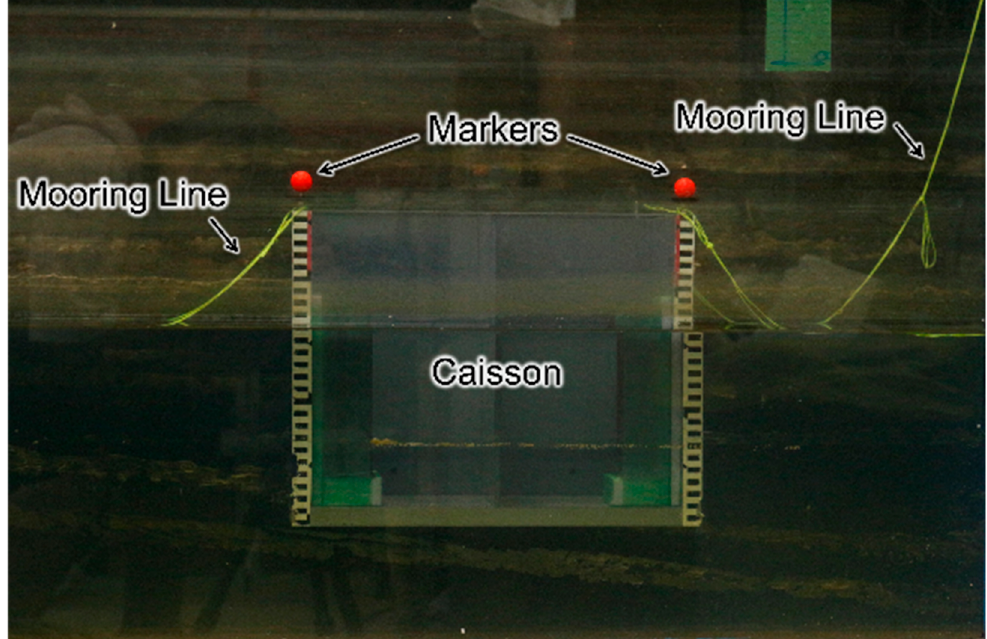
Figure 4. Initial state of the caisson with the markers and mooring lines.